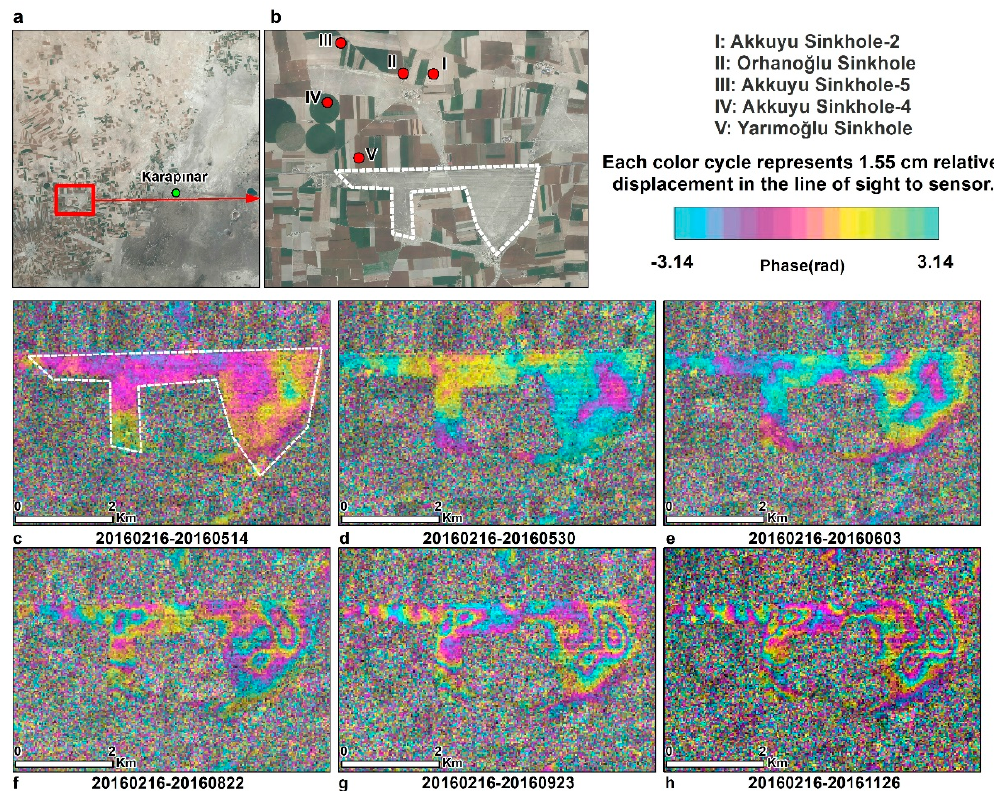
Figure 6. Land subsidence evolution of an area located east of the Karapinar, as observed by COSMO SkyMed Interferograms. ( a ) Orthophoto image showing the location of the subsiding area. ( b ) Zoom-in image of the subsiding area with sinkhole locations. ( c , d ) Three-month interferogram showing no subsidence. ( e ) Four-month interferogram showing the beginning of the subsidence. ( f ) Six-month interferogram showing 1–2 fringes of subsidence. ( g ) Seven-month interferogram showing 2–3 subsidence fringes. ( h ) Nine-month interferogram showing 3–4 subsidence fringes, mostly in the east part of the subsiding area.